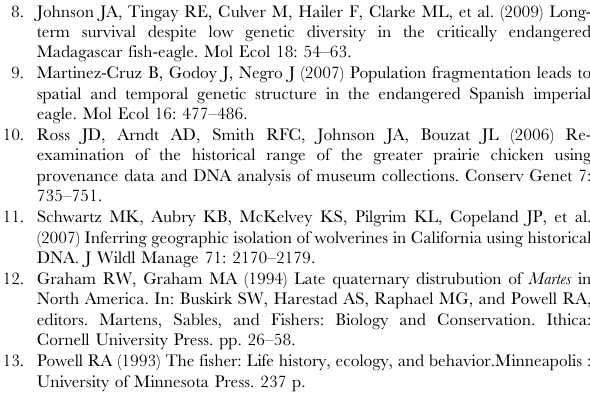
Table S1 Location and collection date of historical fisher genetic samples. Samples were collected from the Smithsonian National Museum of Natural History (SNM) and the Museum of Vertebrate Zoology at the University of California, Berkeley (MVZ). Samples that successfully genotyped at a minimum of 7 of 10 microsatellite loci are shown in bold. Table S2 Prior and hyperprior parameters for runs of the Storz and Beaumont (2002) analysis implemented in MSVAR. Columns 3–6 show the starting values for the mean and variance of the prior distributions. Columns 7–10 show the means and variances (and their means and variances) of the hyperprior distributions. Parameters listed are generation interval (g), current N e ( N 0 ), ancestral N e ( N 1 ), mutation rate scaled in terms of current population size ( h ), and time ( T ). All values are in a log 10